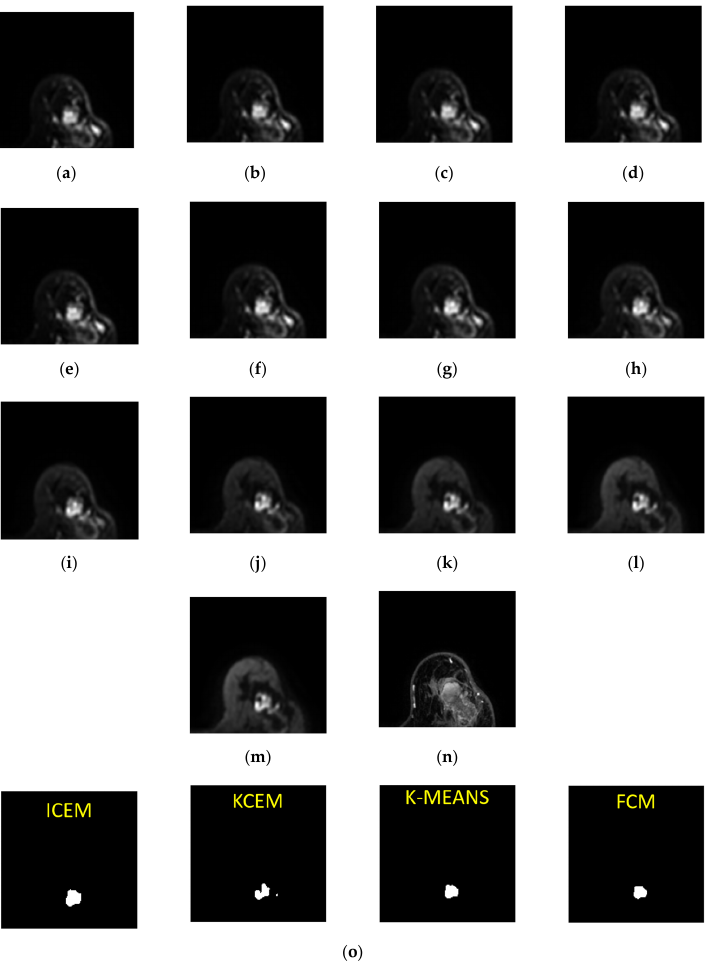
Figure 15. Eighth-slice IVIM-DW images of a cyst with b values of ( a ) 0, ( b ) 15, ( c ) 30, ( d ) 45, ( e ) 60, ( f ) 100, ( g ) 200, ( h ) 400, ( i ) 600, ( j ) 1000, ( k ) 1500, ( l ) 2000, and ( m ) 2500 s/mm 2 . ( n ) Dynamic contrast-enhanced T1-MR imaging. ( o ) Tumor detection by I-CEM, K-CEM, K-means, and FCM.